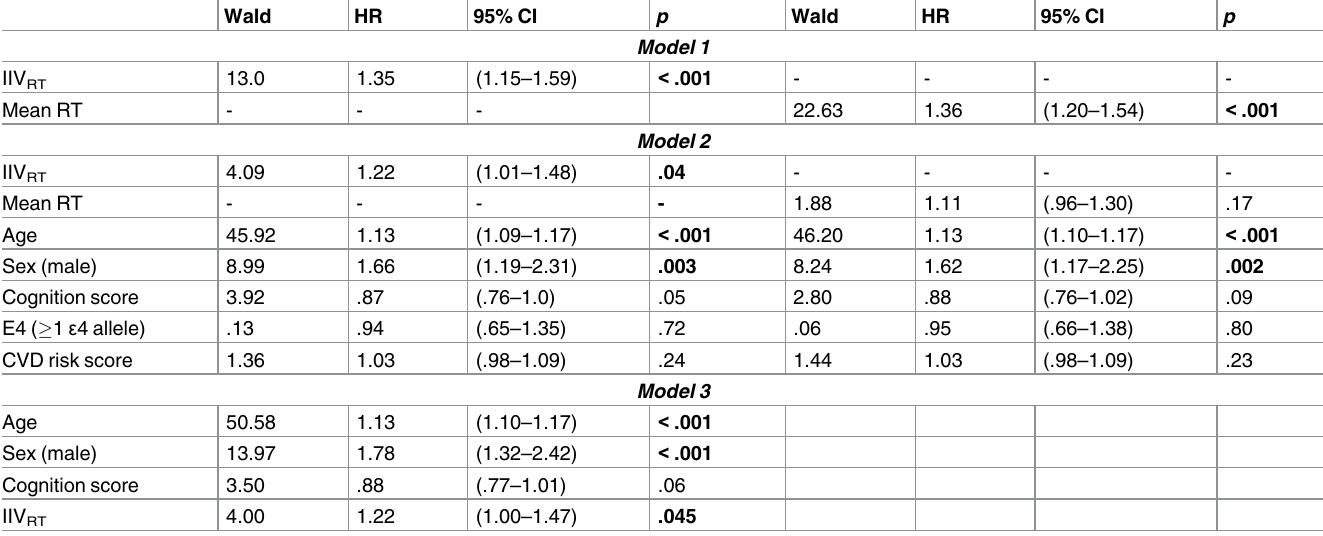
Table 3. Cox proportional hazards regression models of all-cause mortality over 8 yearsfor IIV RT (left side) and Mean RT (right